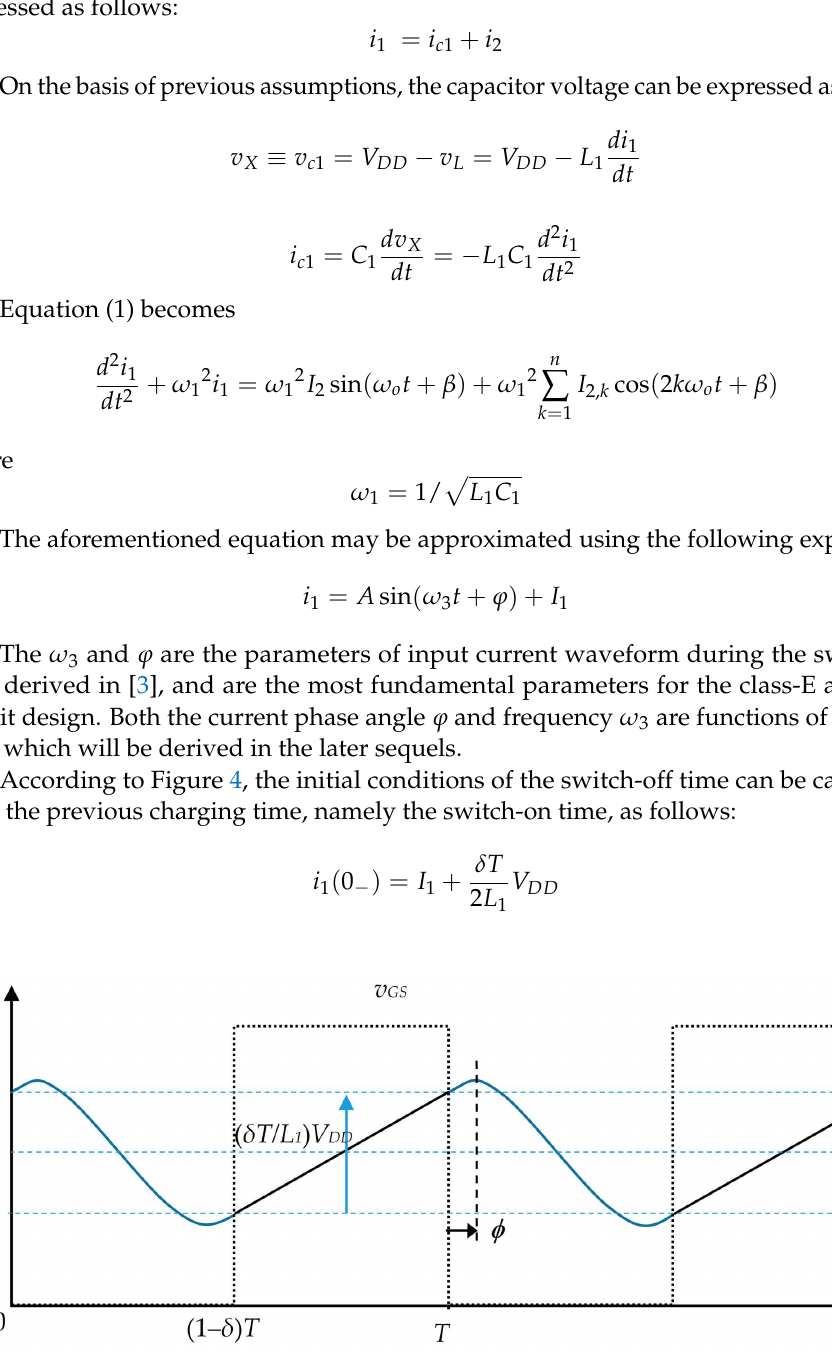
Figure 4. Input current ( i 1 ) of the switching power supply side of the class-E